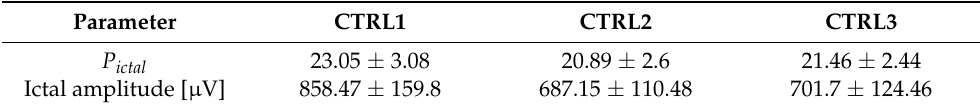
Table 2. P ictal in the CTRL phases of the lognormal versus matched periodic stimulation dataset. Parameter CTRL1